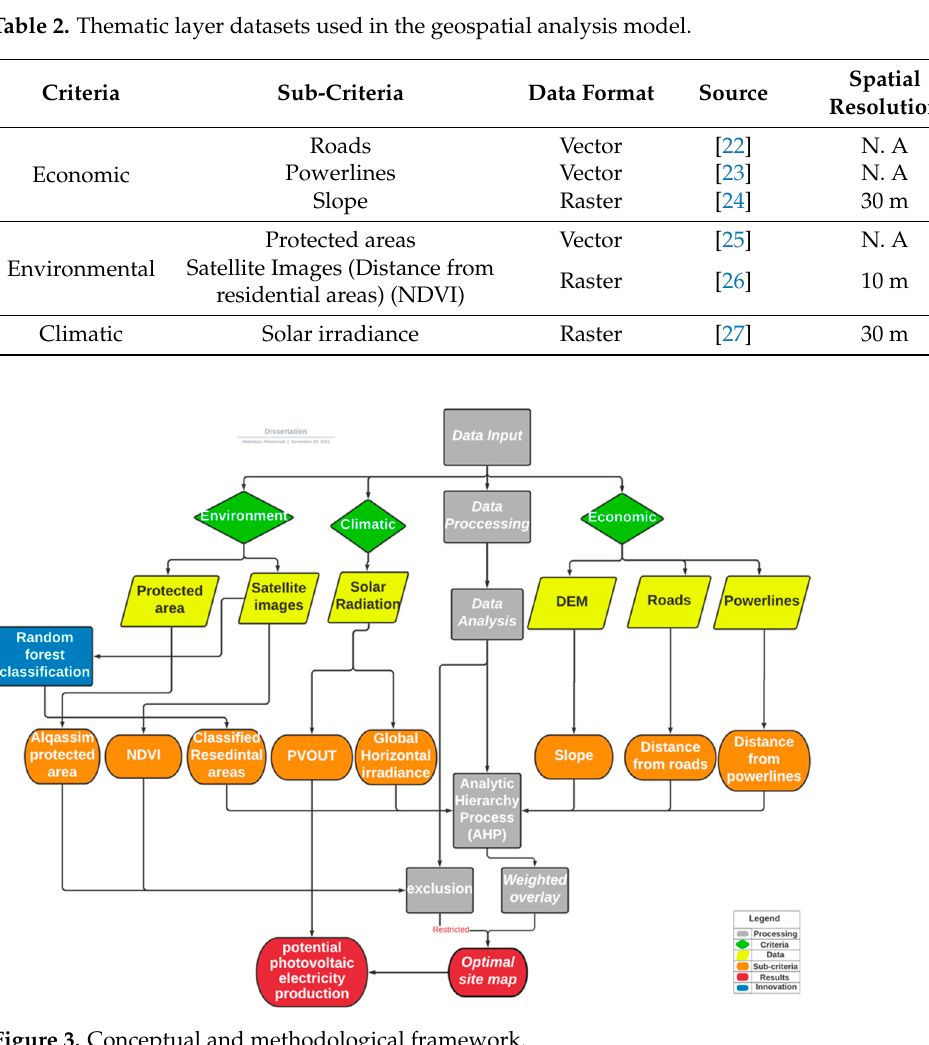
Figure 3. Conceptual and methodological